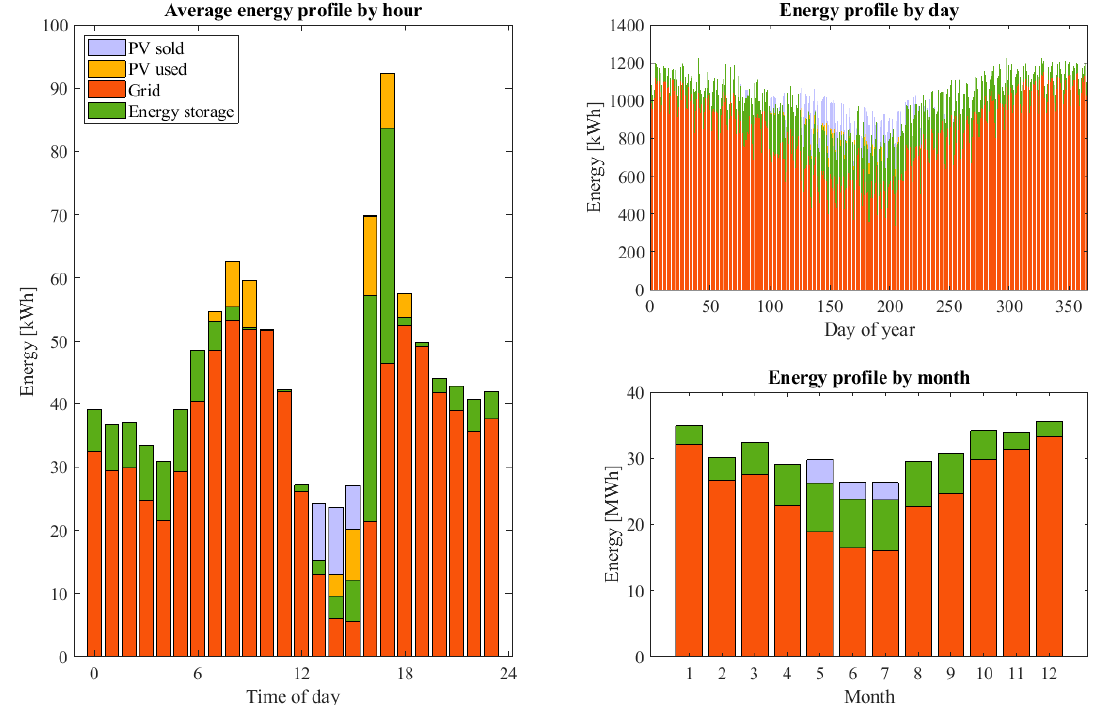
Figure 14. Average energy profiles by hour, day, and month in scenario 2.b.